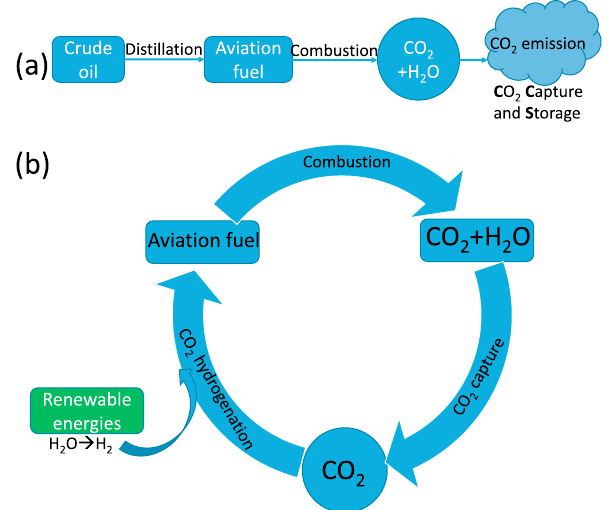
Fig. 6 llustrating the differences between ( a ) an Aviation Jet Fuel Linear Economy and ( b ) an Aviation Jet Fuel Circular